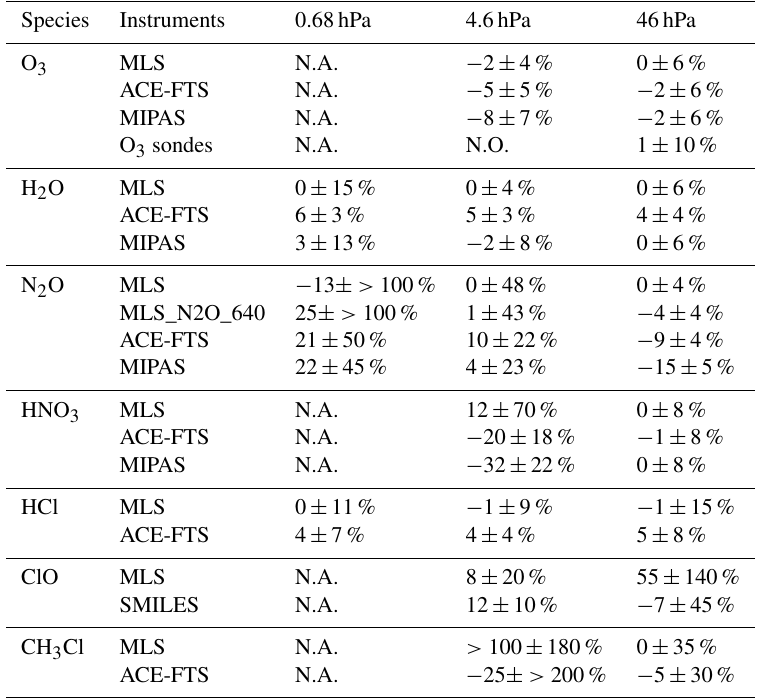
Table 1. Mean difference and standard deviation between BRAM2 and observations for the 2005–2017 period at three specific levels in the middle stratosphere: 0.68, 4.6 and 46hPa. Values are in percent, normalized by BRAM2. Abbreviations: not assimilated (N.A.) and not observed